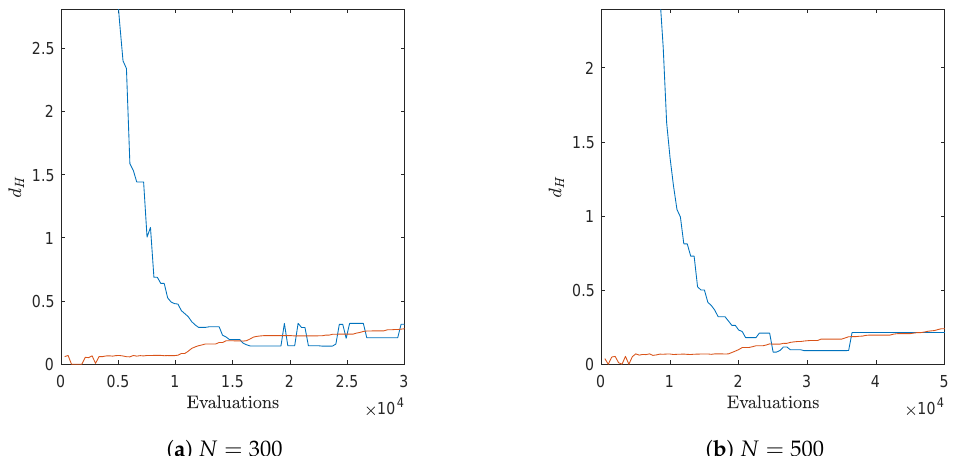
Figure 10. Real (blue) and approximated (red) Hausdorff distances during the run of one algorithm for